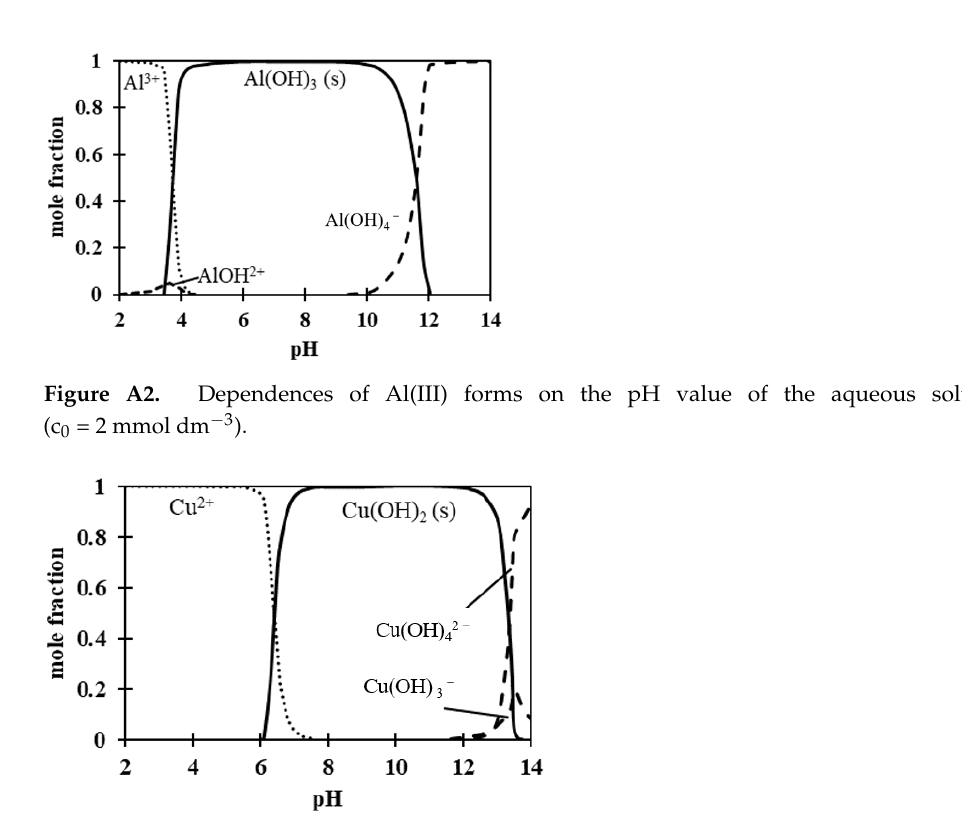
Figure A1. Dependences of Al(III) forms on the pH value of the aqueous solutions (c 0 = 0.15 mmol dm -3 ).